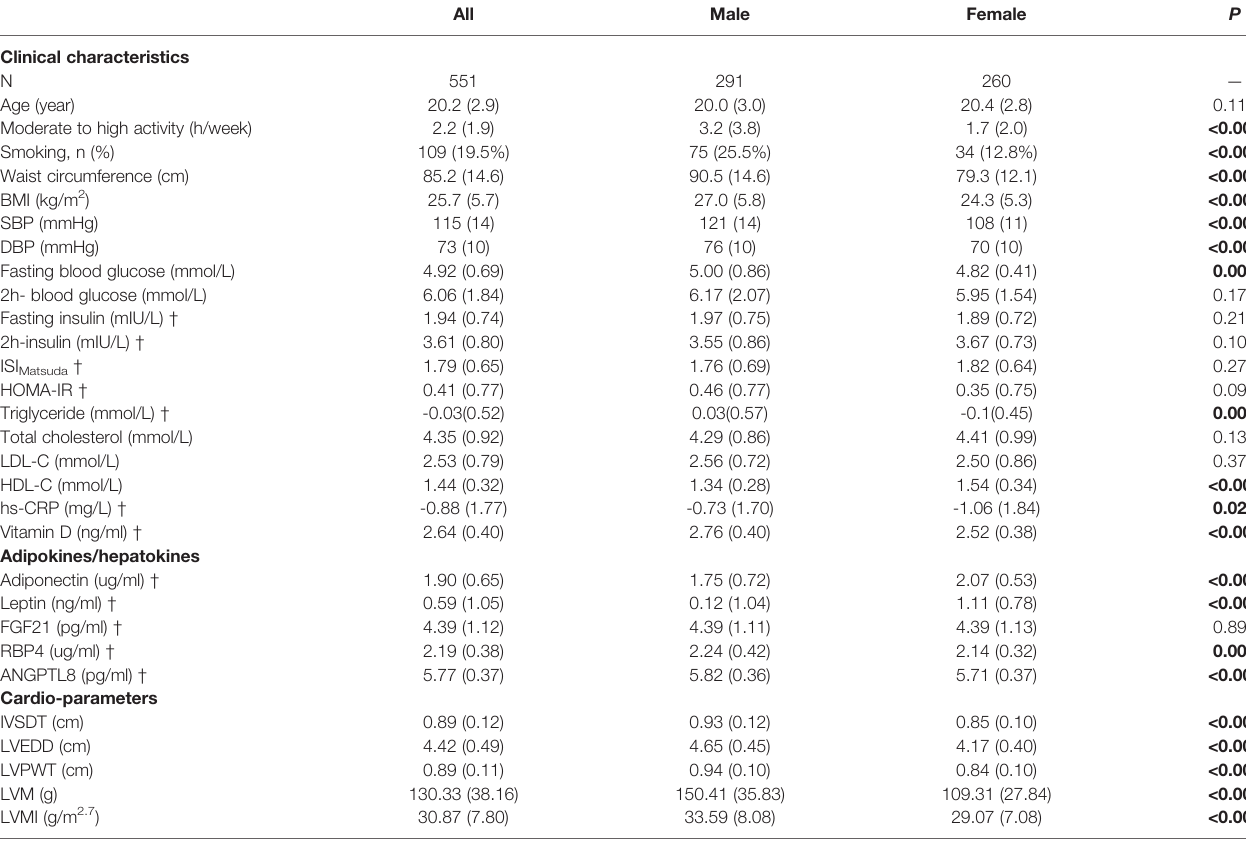
TABLE 1 | Characteristics of